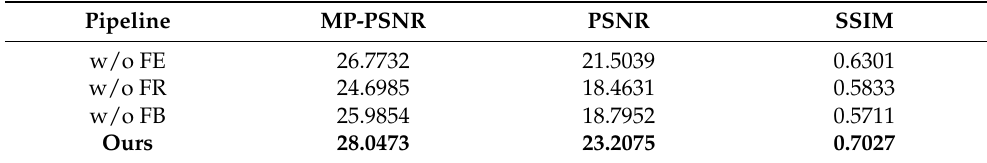
Table 1. Ablation studies on flow estimation by Surround 360 [23], flow-based reconstruction, and flow-based